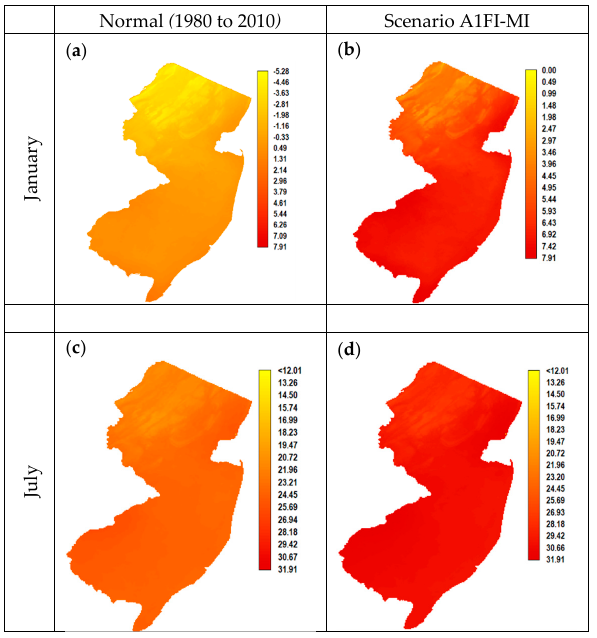
Figure 5. Change in average monthly temperatures: 30-year normal compared to projected A1FI-MI scenario (January ( a , b ), and July ( c , d )). The temperature di ff erence between normal and A1FI-MI is represented by the reddish and yellowish colors. The lighter yellowish color ( a ) is colder than the reddish in January ( b ). July is represented by redder colors than January where the cooler temperatures are represented by light red color under normal temperature conditions ( c ). Hotter temperatures are in dark red under A1FI-MI scenario ( d ). (Refer to the legend to the right for related numerical